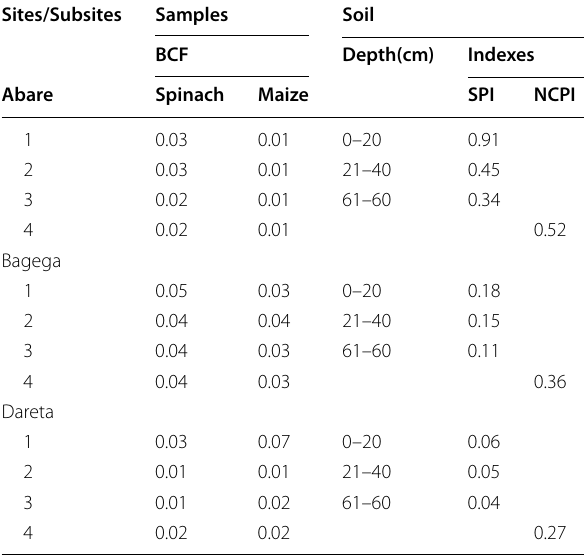
SPI-Single pollution index, NCPI-Nemerow composite pollution index; data are mean SD (n 3); SPI and NCPI < 1 ± = limit thus, unsafe;